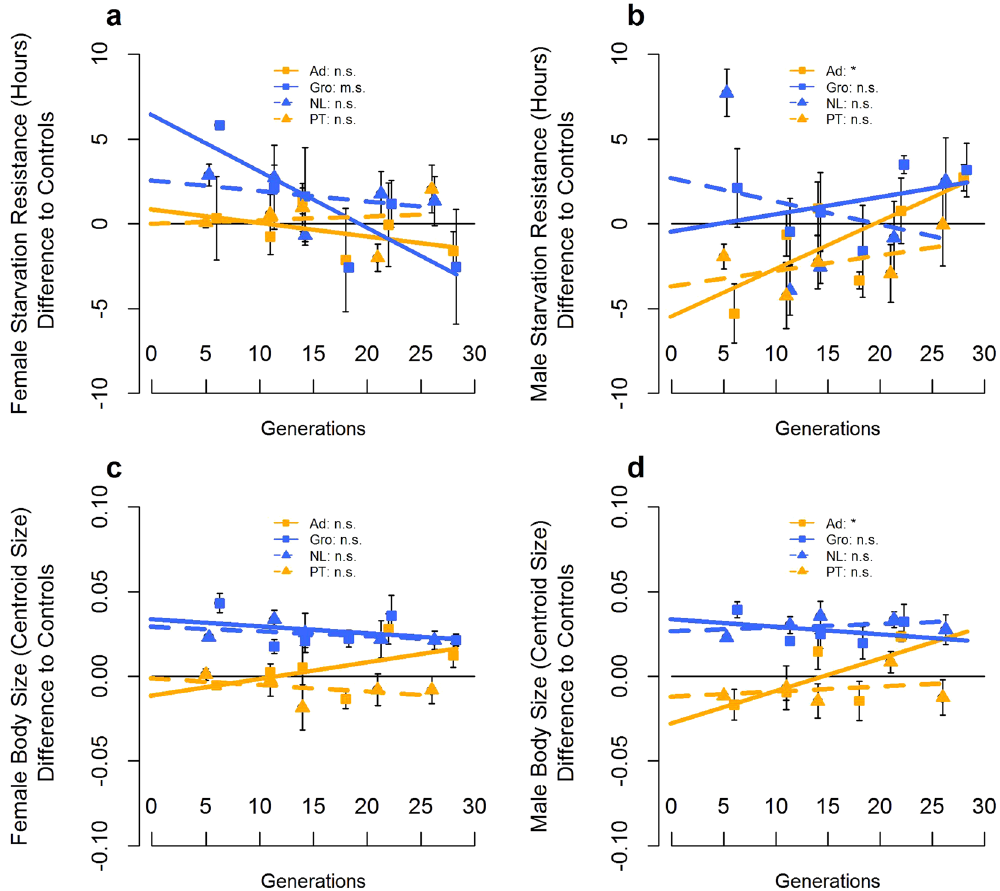
Figure 2. Evolutionary trajectories for starvation resistance and body size. Female Starvation Resistance ( a ), Male Starvation Resistance ( b ), Female Body Size ( c ) and Male Body Size ( d ) are presented for each foundation, as well as the corresponding linear regression models. See details in the legend of Fig.